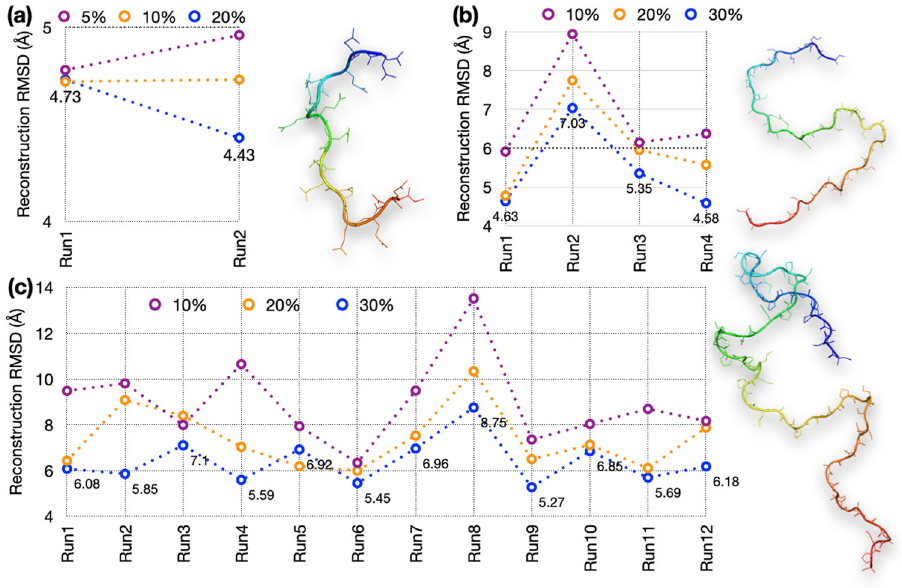
Fig. 2 Average reconstruction RMSDs at different sizes of the training sets sampled from replicate MD runs. a Q15 at 5%, 10%, and 20% training sizes from two runs. b A β 40 at 10%, 20%, and 30% training sizes from four runs. c ChiZ at 10%, 20%, and 30% training sizes from 12 runs. A structure for each IDP is